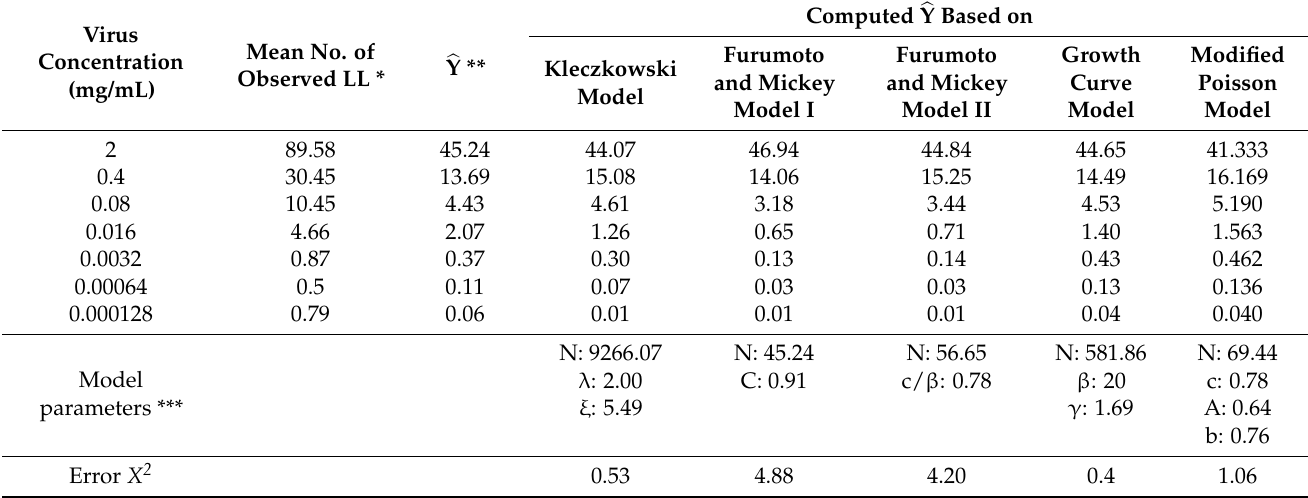
Table 2. Mean number of observed necrotic local lesions on N. tabacum cv. Xanthi nc with serially diluted ToBRFV suspensions and related means of transformed data and computed data based on the different models. Data transformation performed according to Section